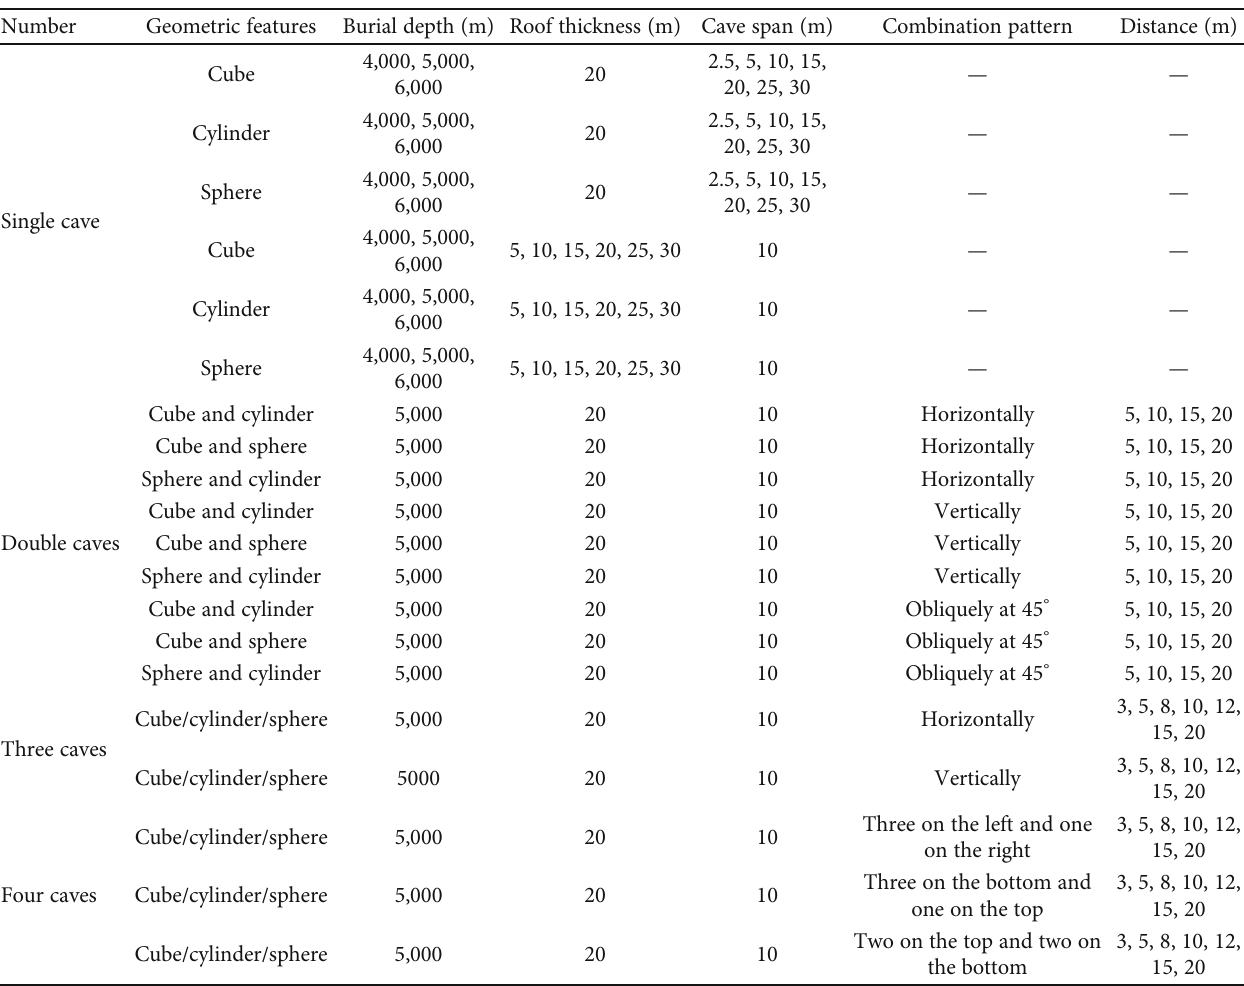
Figure 4: Numerical model and boundary conditions of karst cave. Table 2: Summary of numerical simulation